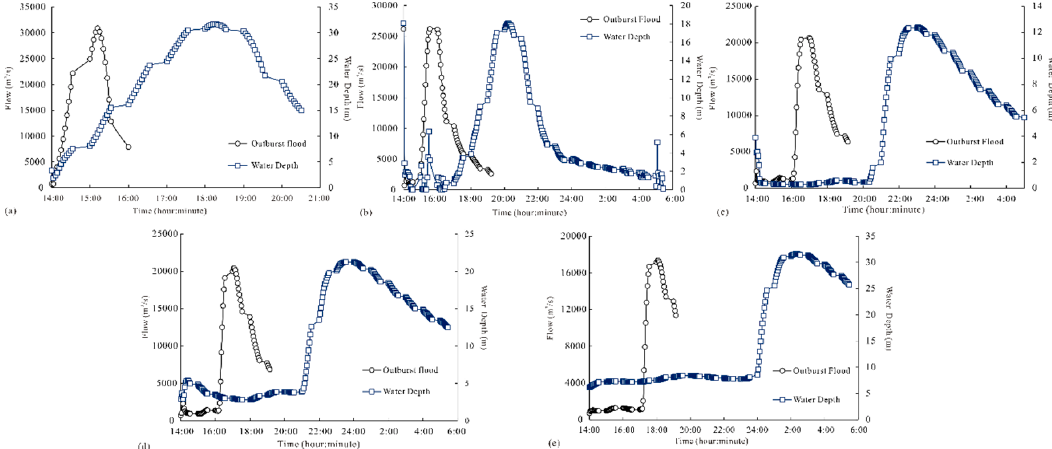
Figure 12. Comparison of water depth curves and outburst flood curves: ( a ) curves at the Baige landslide dam; ( b ) curves at the Yebatan arch dam; ( c ) curves at the Lawa hydropower station; ( d ) curves at the Batang hydropower station; ( e ) curves at the Suwalong hydropower station.